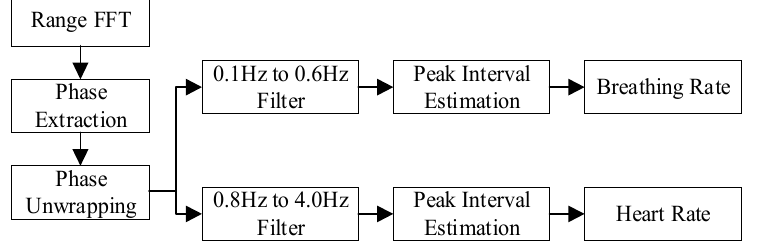
Figure 14. The two band pass filters were set to 0.1–0.6 Hz and 0.8–4.0 Hz corresponding to the respiratory and heartbeat bands, respectively, where the respiratory filter start frequency was 0.1 Hz to filter out the interference of DC noise [9–12].